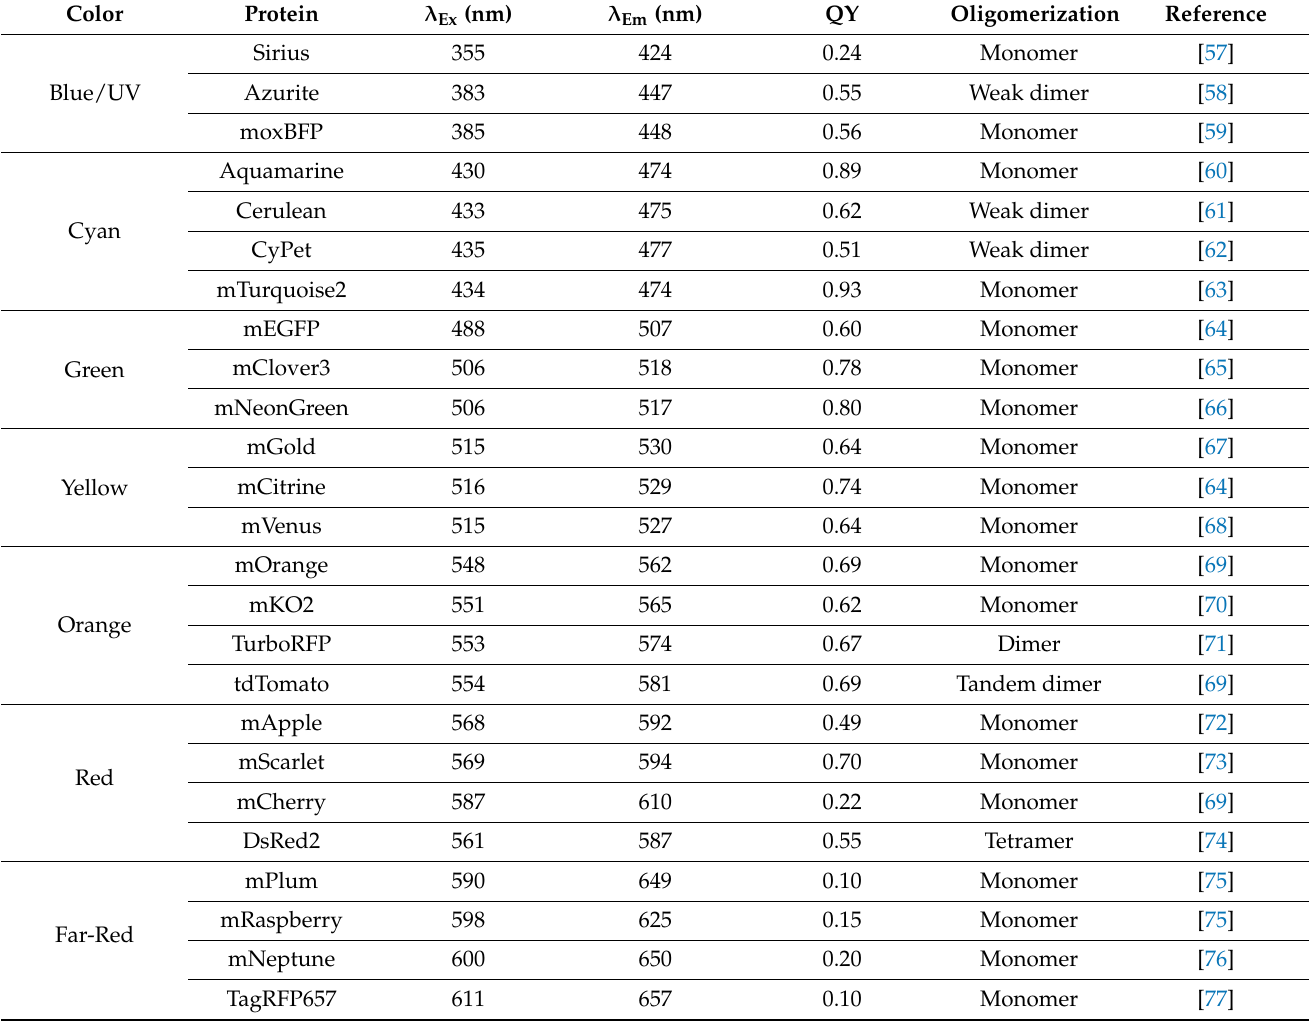
Table 2. Classification of fluorescent proteins based on the fluorescence emission wavelength.